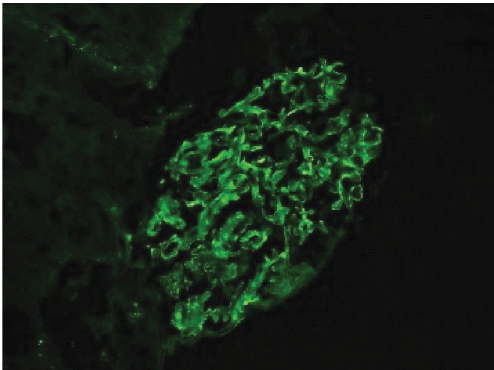
Figure 3: Immunofluorescence stained for IgA.